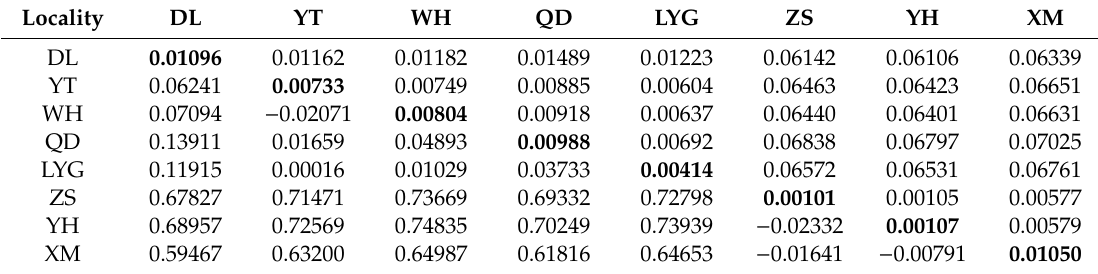
Table 3. Kimura 2-parameter model distance (above diagonal) and fixation index (F ST ) (below diagonal) between localities based on the combined sequences of COI and 16S rRNA segments of A. rubrolineatus. Values in the diagonal with a bold font are average K2P distances within geographic